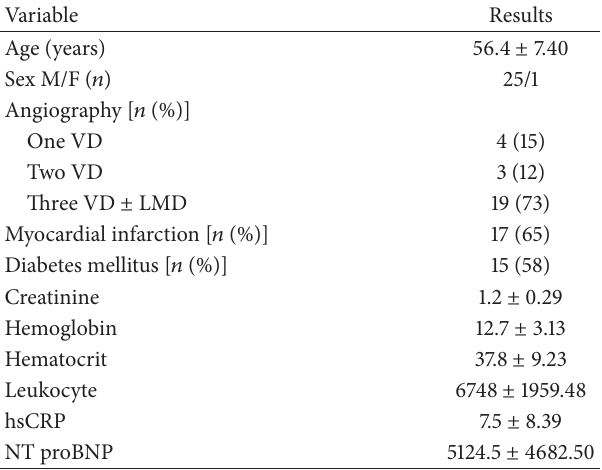
Table 1: Clinical